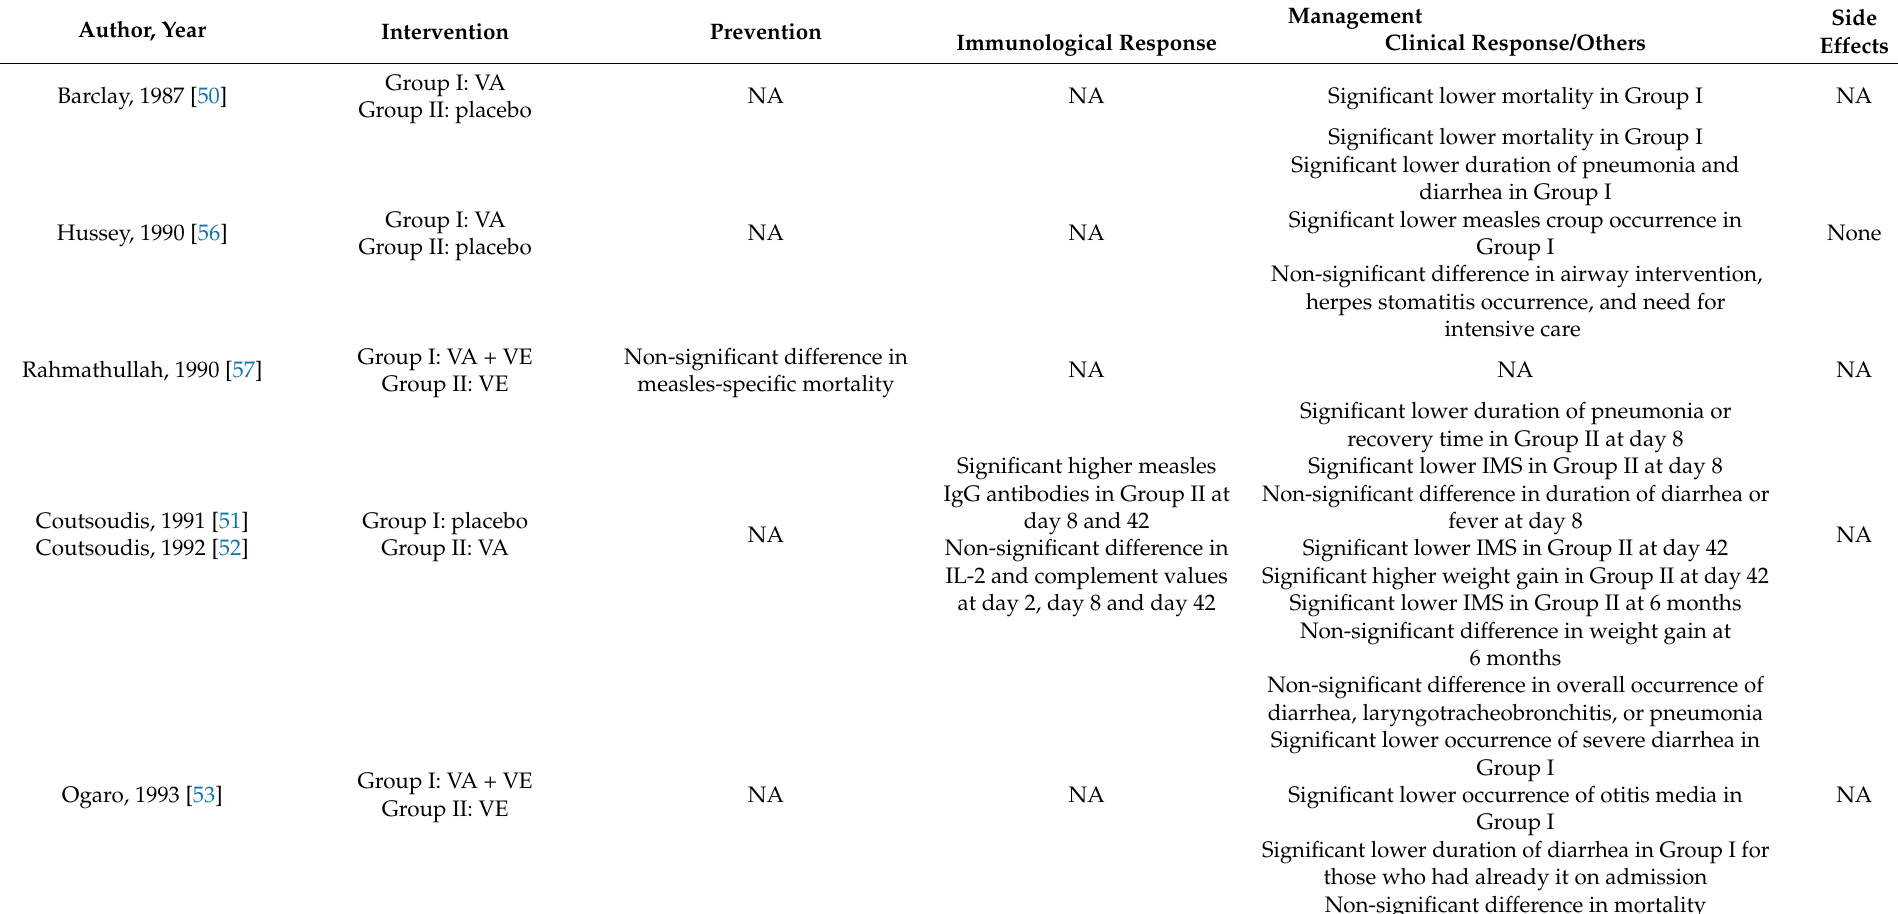
Table 4. Main effects of Vitamin A (VA) oral administration in the prevention and management of infections sustained by measles